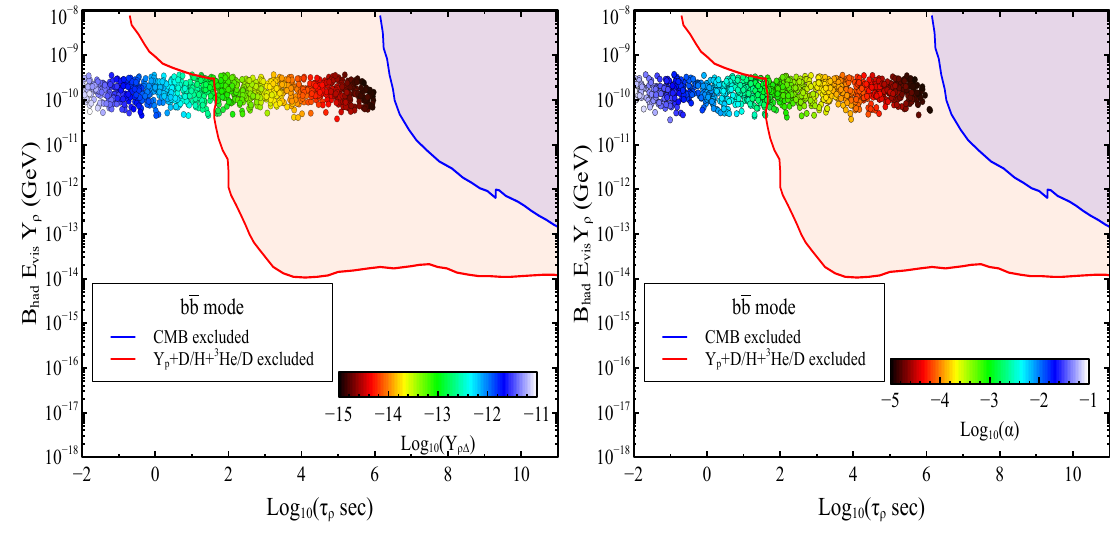
Figure 16 . Scatter plot in the plane injected hadronic energy through out-of-equillibrium decay of ρ plane and lifetime of ρ for (LP), 10 − 15 < Y 10 − 11 and sin α = 0 . 1 and (RP) Y = 10 − 11 ρ ∆ < ρ ∆ and 10 − 5 < sin α < 10 − 1 . All points in the RP and LP satisfy the DM relic density constraints in 3 σ range. The solid red line denotes the BBN constraint which arises from observed light elements abundance [32]. The region above solid blue line is excluded by the CMB spectral distortion